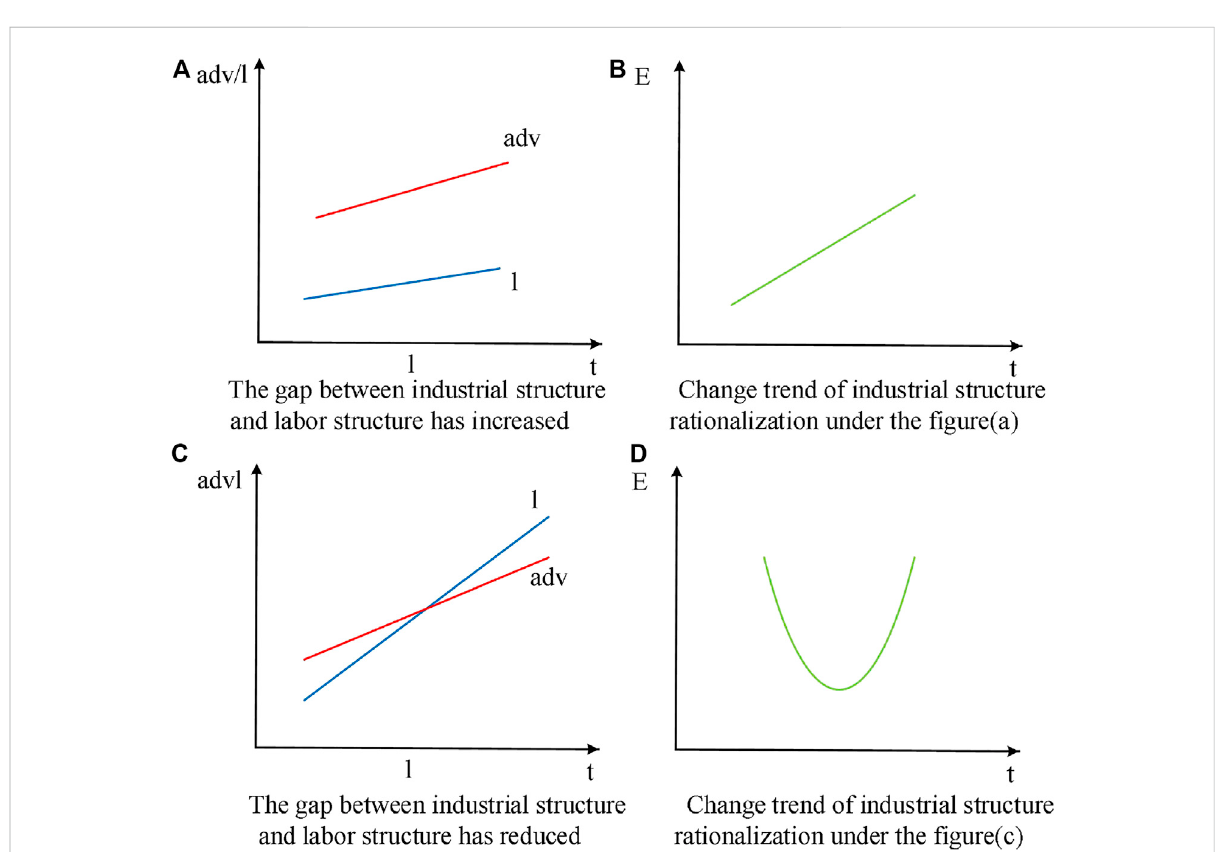
FIGURE 5 The relationship between industrial structure upgrading, rationalization and labor force